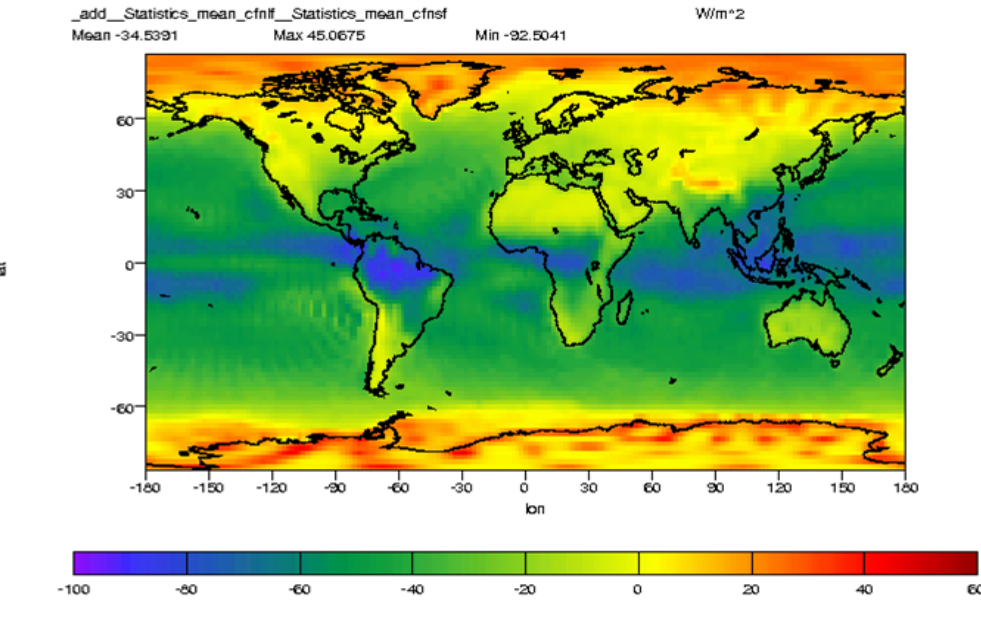
Figure 1. Net cooling induced by the global cloud field as given by the NCEP reanalysis data. The net cooling is especially pronounced in the equatorial belt. In the polar regions the planetary albedo is not increased by clouds as a consequence of the large surface albedo. Here, the “warming” effect of clouds in the thermal spectra